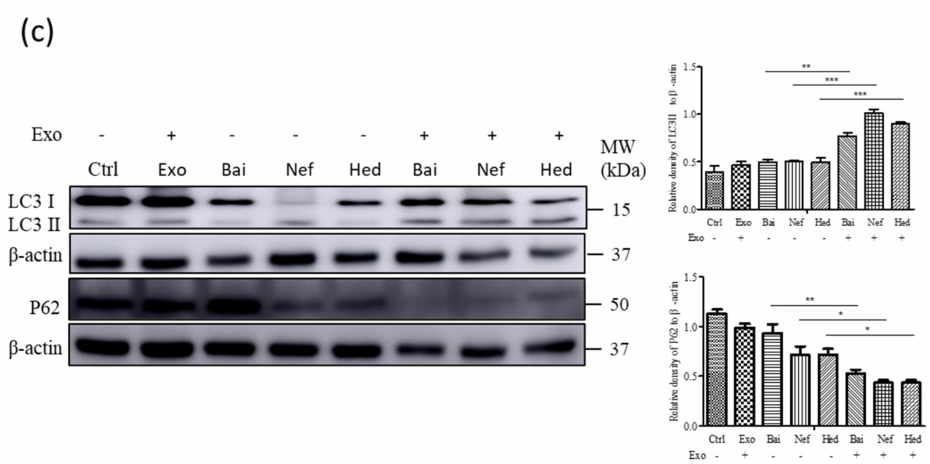
Figure 5. Exosome-encapsulated herbal compounds effectively reduce the expression of neurode- generative diseases proteins. ( a ) Western blot analysis of the GFP-tag of HTT74, P301L tau and A53T α -syn proteins expressed on differentiated PC-12 cells treated by Exo-Bai (50 µ g/mL), Exo-Hed (2 µ g/mL), Exo-Nef (0.5 µ g/mL), Bai (50 µ g/mL), Hed (2 µ g/mL) or Nef (0.5 µ g/mL) for 24 h. ( b ) Flow cytometry analysis of the GFP signal of HTT74, P301L tau and A53T α -syn of differen- tiated PC-12 cells treated by Exo-Bai (50 µ g/mL), Exo-Hed (2 µ g/mL), Exo-Nef (0.5 µ g/mL), Bai (50 µ g/mL), Hed (2 µ g/mL) or Nef (0.5 µ g/mL) for 24 h. ( c ) Western blot analysis of LC3, P62 and β -actin after 24 h of treatment at the conditions as indicated above. All of the experiments